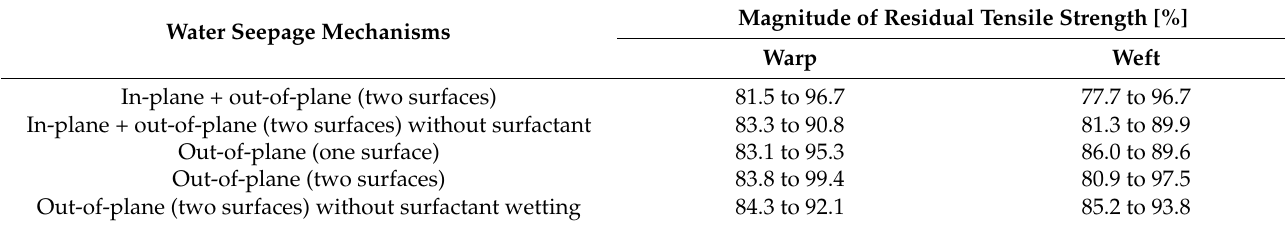
Table 6. Residual tensile strength of glass-PTFE for different water seepage